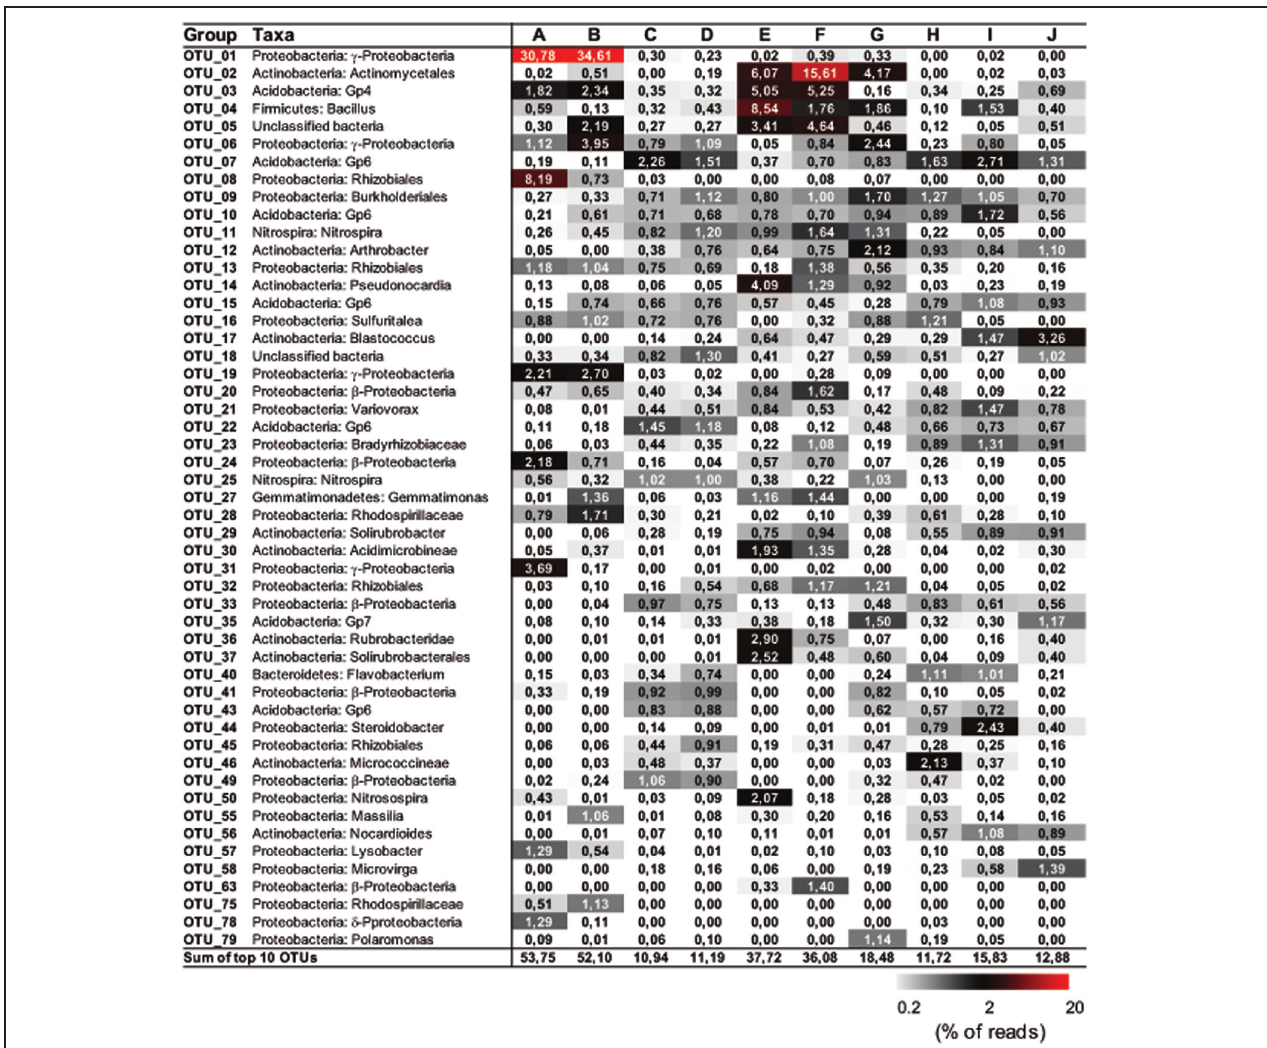
FIGURE 3 | Distribution matrix with the 10 most abundant taxa in each sample. Abundances are based on DNA amplicons. Taxa were defined by using Classifier of RDP with 80% selected as a threshold. Numbers show the